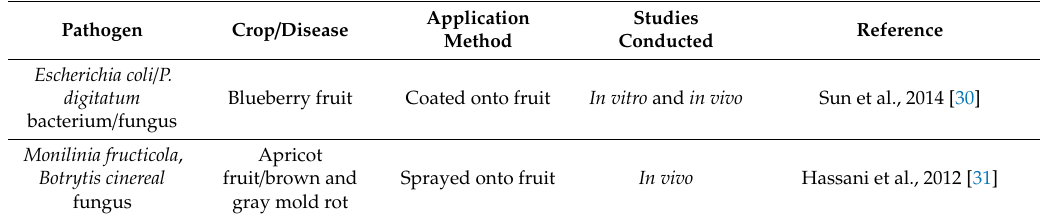
Table 2. Effect of carvacrol on pathogenic fungi and bacteria in media.